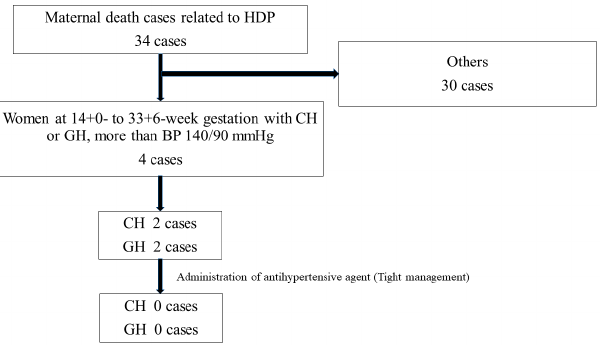
Figure 1. Patients without proteinuria and whose BP exceeded 140/90 mmHg between 14+0 and 33+6 weeks of gestation (CH and GH).